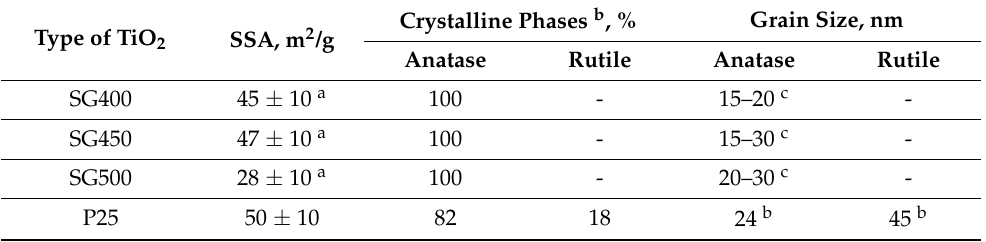
Table 1. Textural and structural properties of the studied TiO 2 support